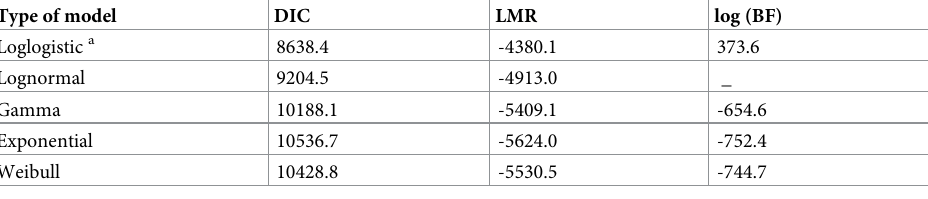
Table 3. Model comparison parameter on time of early neonatal death in Ethiopia.